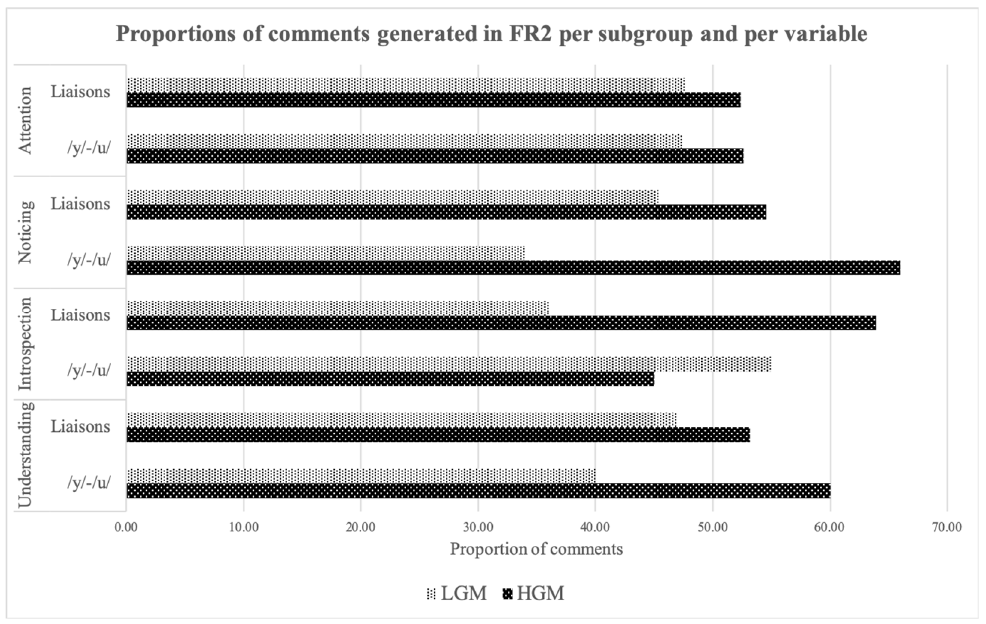
Figure 4. Proportions of comments generated in FR2. FR3. Figure 5 represents the proportion of comments generated by FR3 per subgroup (HGM and LGM), per type of statements, and per variables.